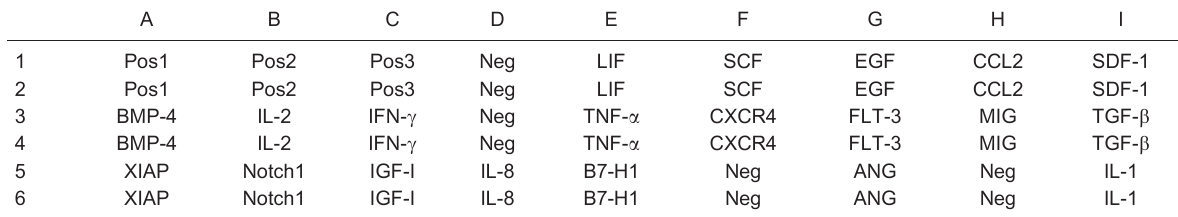
LIF: leukemia inhibitory factor; SCF: stem cell factor; SDF-1: stromal cell-derived factor; BMP-4: bone morphogenetic protein 4; FLT-3: HSC-stimulating factor; TGF- b : transforming growth factor- b ; IFN- c : interferon- c ; TNF- a : tumor necrosis factor- a ; B7-H1: programmed death ligand; Pos: photoreceptor outer segment proteins; Neg: endo-1,6-beta-D-glucanase; EGF: epidermal growth factor; CCL2: monocyte chemoattractant protein 1; CXCR4: CXC chemokine receptor-4; IL-2: interleukin-2; MIG: membrane immunoglobulin; XIAP: X-linked inhibitor of apoptosis; Notch1: neurogenic locus notch homolog protein 1.